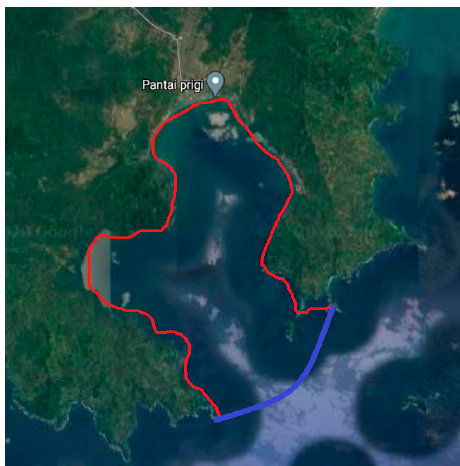
Figure 5. Boundary condition for Prigi Bay (red line is land boundary and blue line is open ocean boundary).